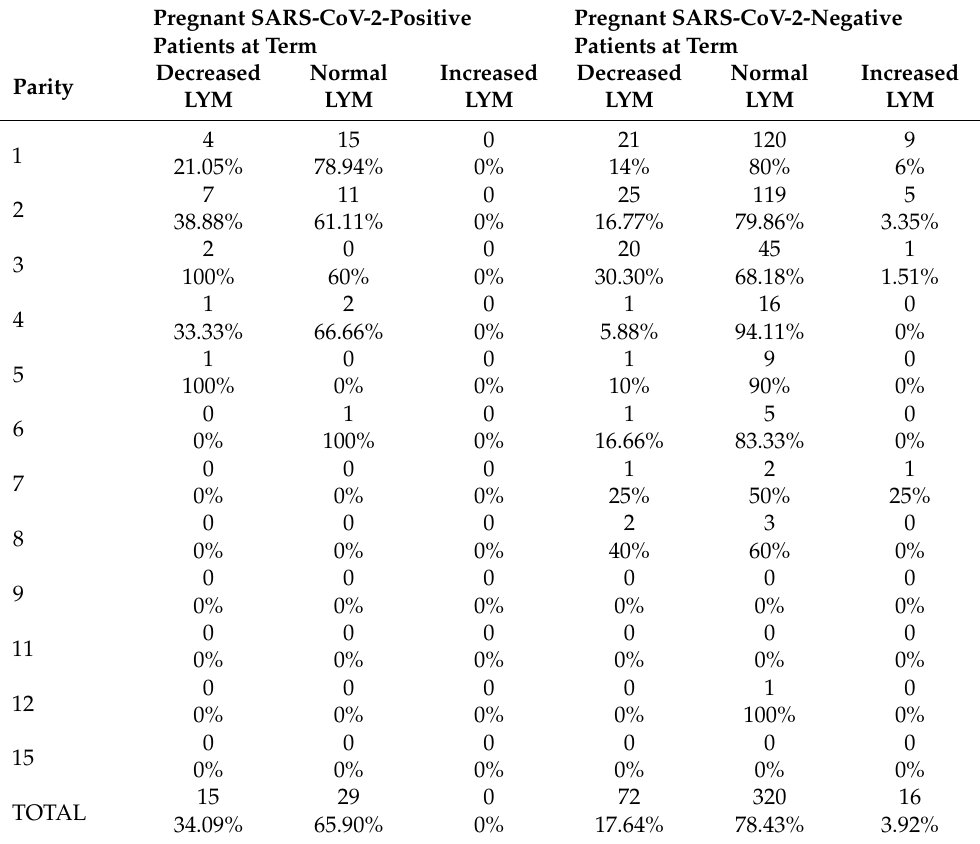
Table 8. Number and percent of pregnant patients with a normal, increased, and decreased number of lymphocytes, as regards parity. Pregnant SARS-CoV-2-Positive Patients at